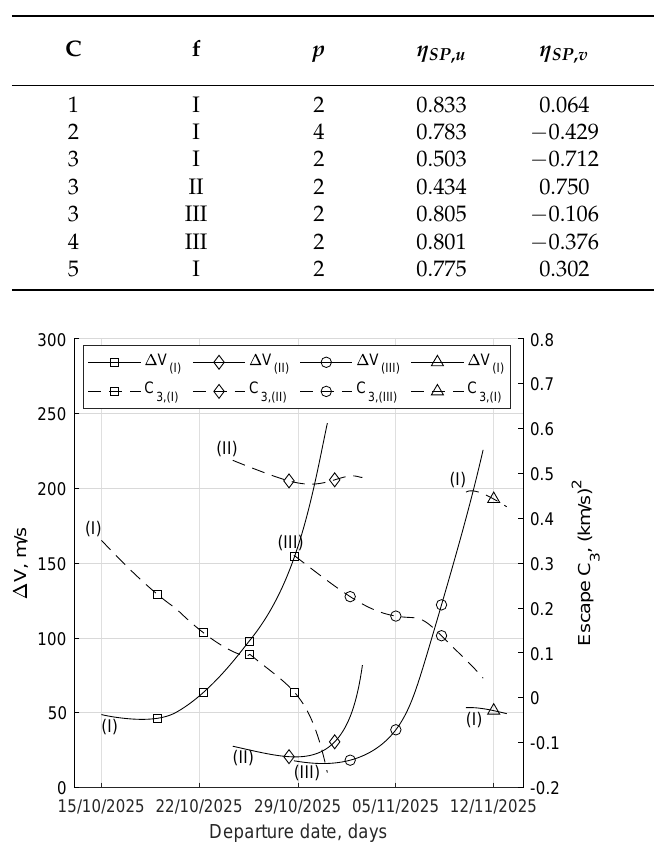
Figure 13. EML2 escape trajectories—fixed t f = 75 days, free C 3 , EME2000 RF. Table 4. EML2 escapes performance—fixed t f = 75 days, free C 3 .